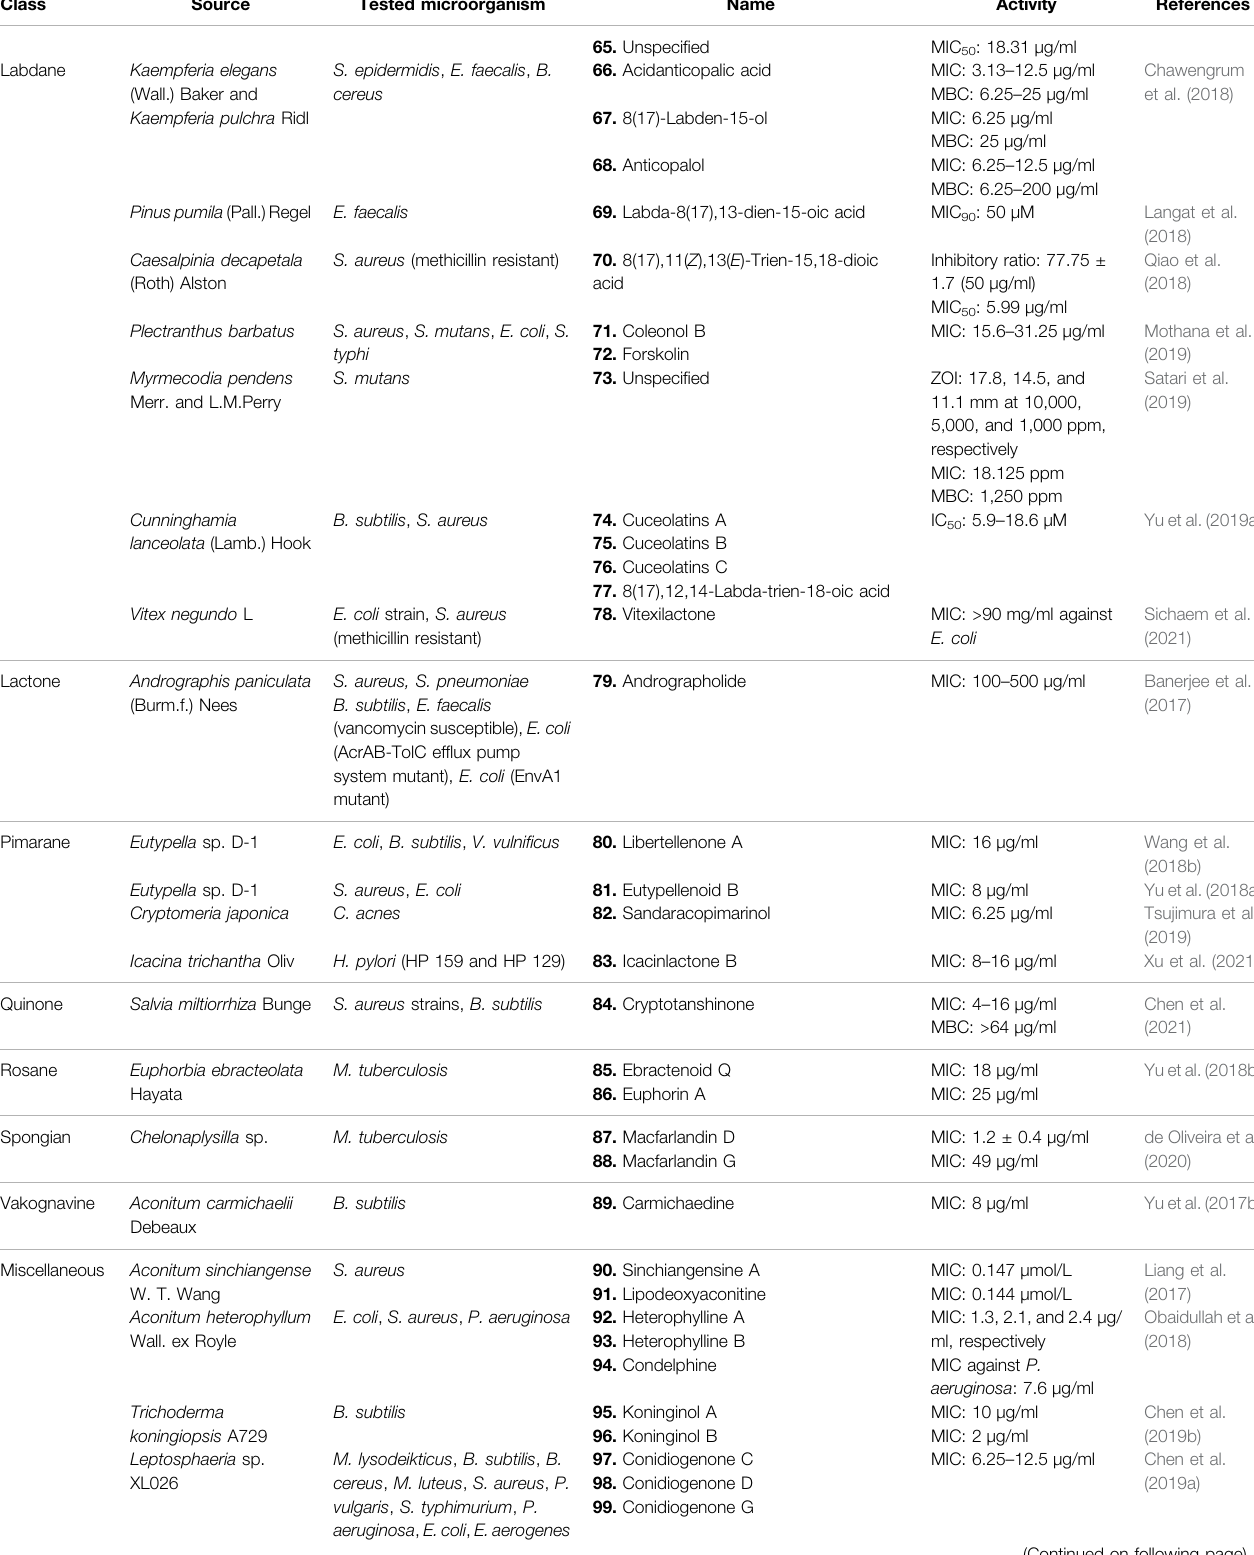
TABLE 1 | ( Continued ) Different classes of diterpenoids isolated from natural sources with signi fi cant antibacterial